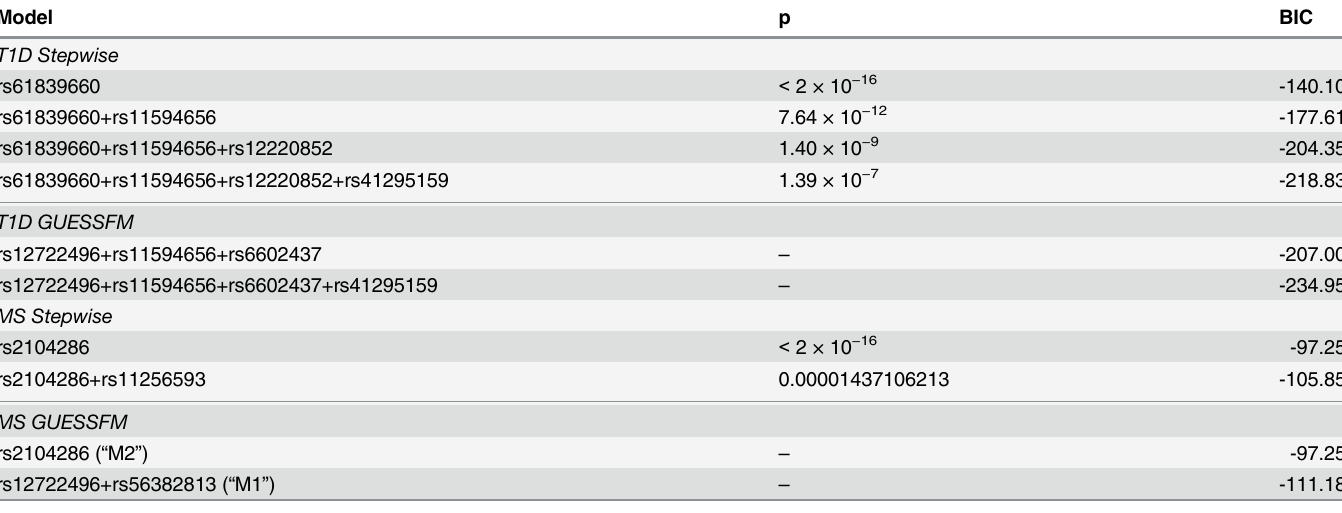
Table 1. Comparison of results from stochastic GUESSFM and stepwise searches. p values are shown for the stepwise search and compare the listed model to the model above (or the null model, for single SNPs). Bayesian Information Criterion (BIC) is shown for stepwise models and index models found through GUESSFM search.